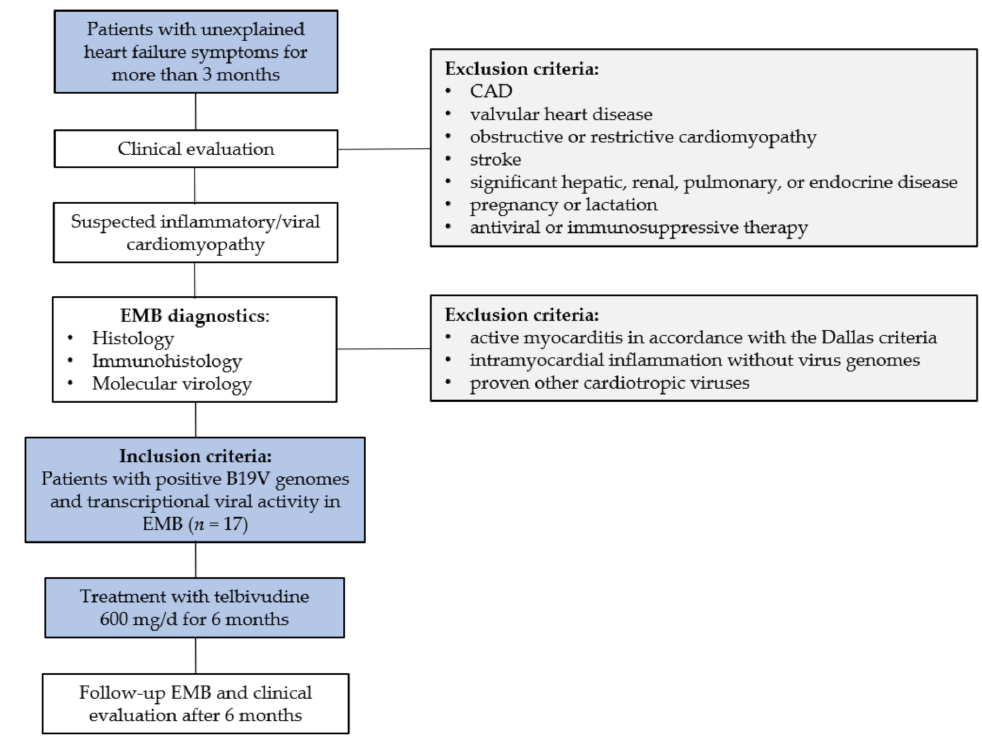
Figure 1. Study treatment scheme of patients with B19V transcriptional activity in EMB. B19V = parvovirus B19; CAD = coronary artery disease; EMB = endomyocardial